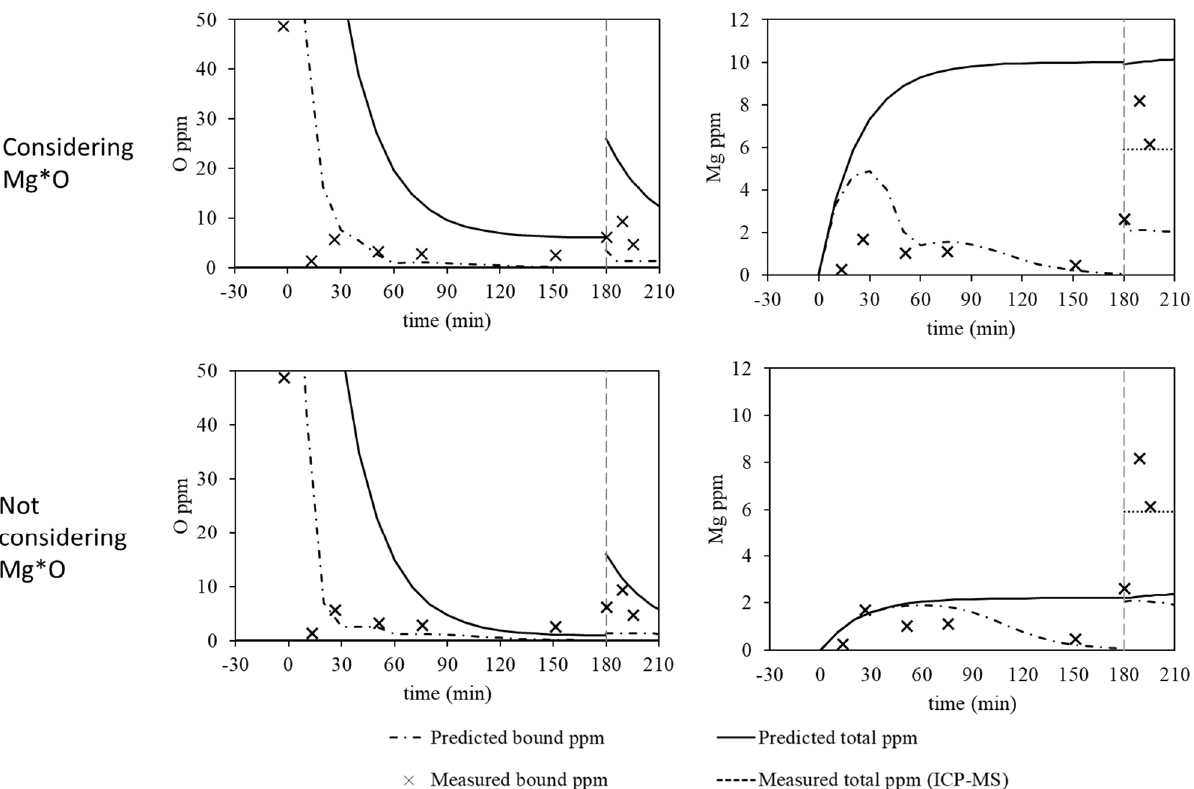
Figure 6. Measured evolution of [S] (markers) and fitted first-order reaction kinetics (lines) considering two equilibrium sulfur concentrations ([S]*): [S]* = 4 ppm (minimum [S] measured in the experimental trial; solid line), and [S]* = 1.2 ppm (FactSage estimate; broken line).